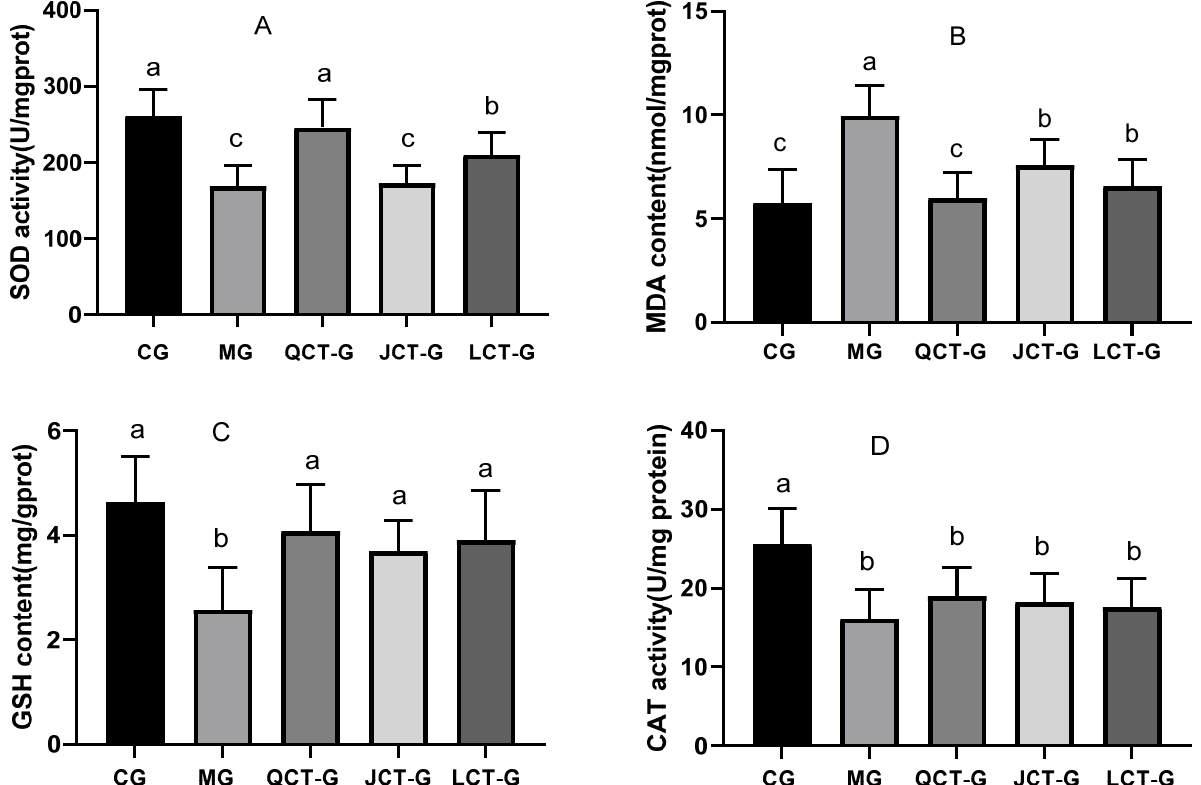
Figure 1. SOD, MDA, GSH, and CAT levels in the liver of mice: ( A ) SOD activity in the liver of mice; ( B ) MDA content in the liver of mice; ( C ) GSH contents in the liver of mice; ( D ) CAT activity in the liver of mice. Values are expressed as mean ± standard deviation ( n = 12 in each group). The same superscript (a, b, or c) in the same column represents no significant differences between values ( p < 0.05).